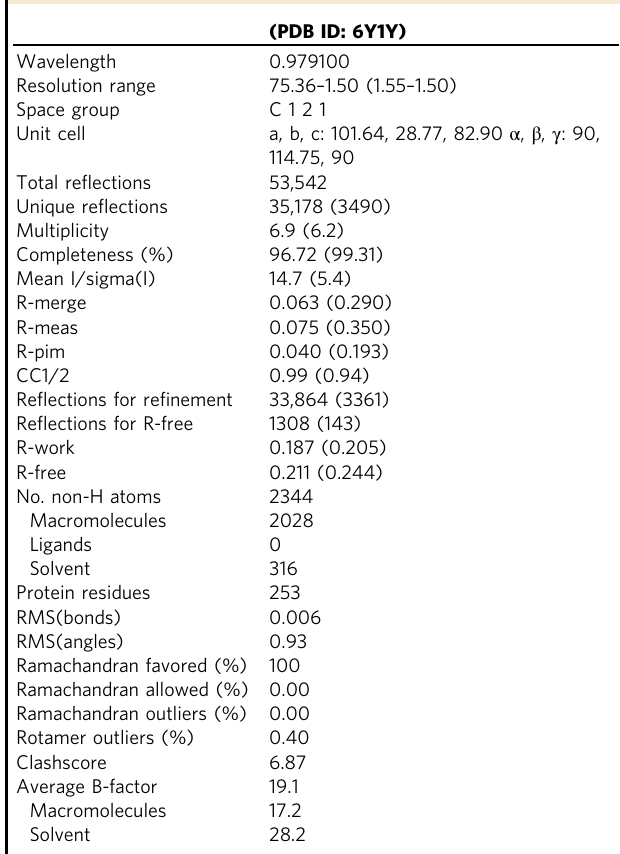
Table 1 Data collection and re fi nement statistics for the